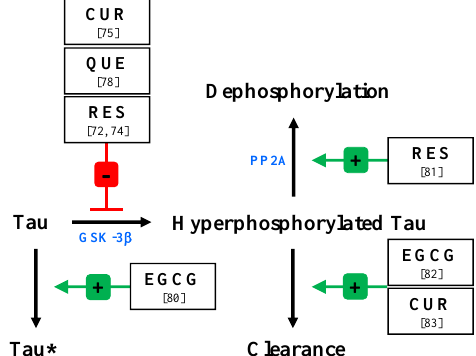
Figure 7. Polyphenols modulate levels of hyperphosphorylated tau by inhibiting GSK-3β activity towards tau, remodeling tau to kinase-resistant tau (tau*), increasing the activity of PP2A towards hyperphosphorylated tau, and enhancing the clearance of hyperphosphorylated tau.